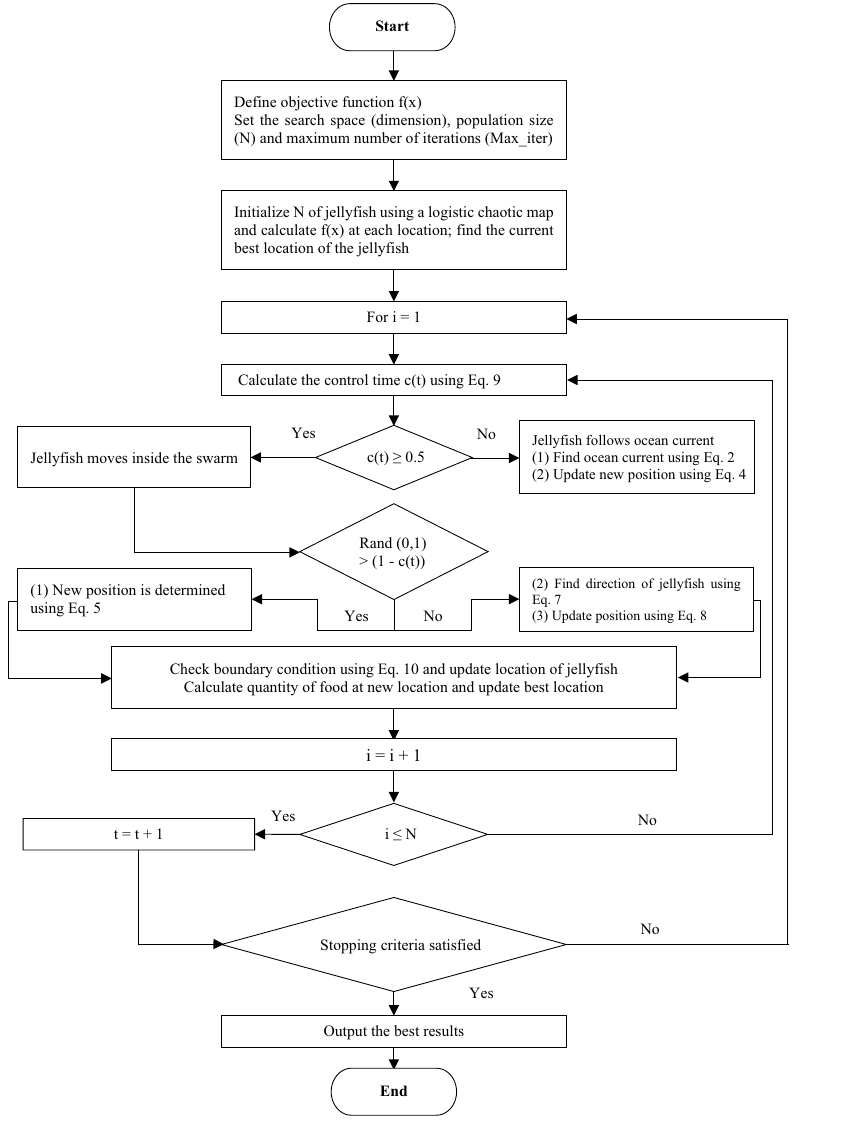
Figure 2. Schematic flowchart of SOJS algorithm, adapted from Ref. 39